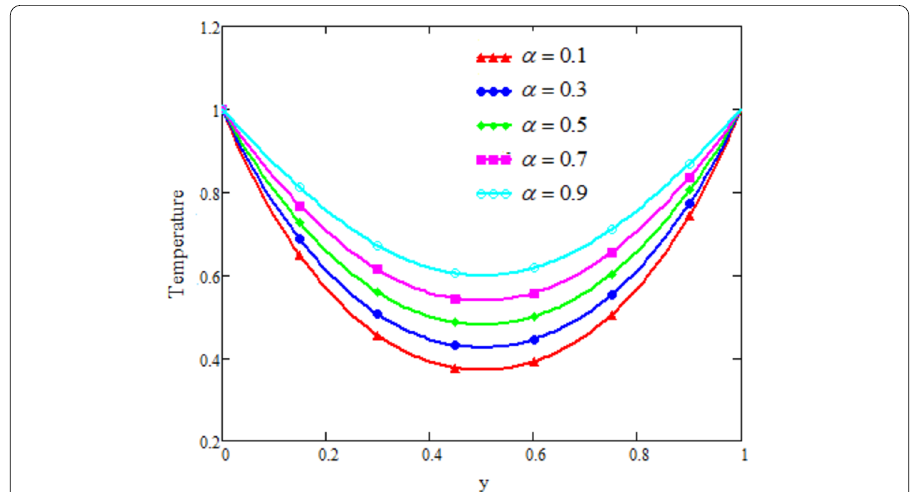
Figure 2 Temperature curves along α variation and P r = 12, t = 1.5